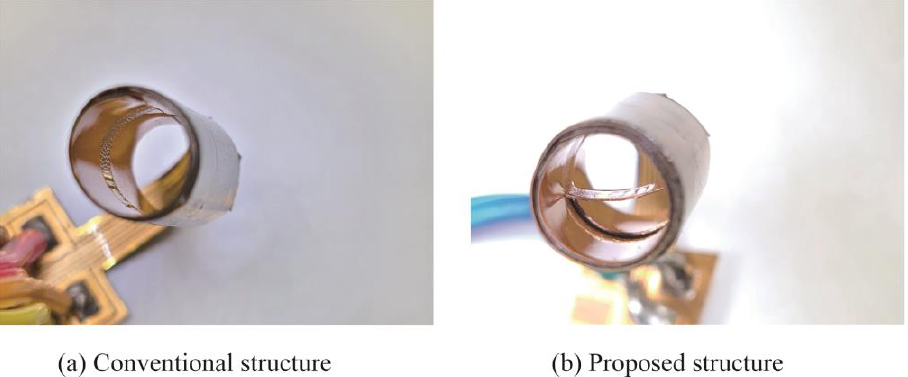
Figure 10. Photograph of a sensor with a conventional structure with the sensing element on the tube wall and the proposed sensor with the sensing element installed at the center of the tube.